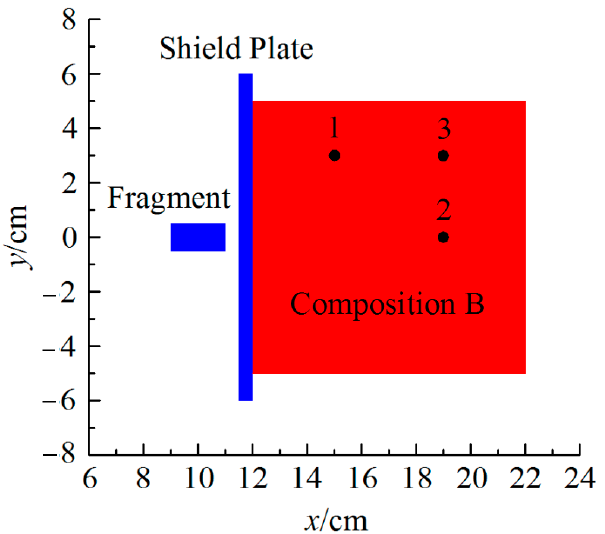
Figure 3. The numerical model of the example.